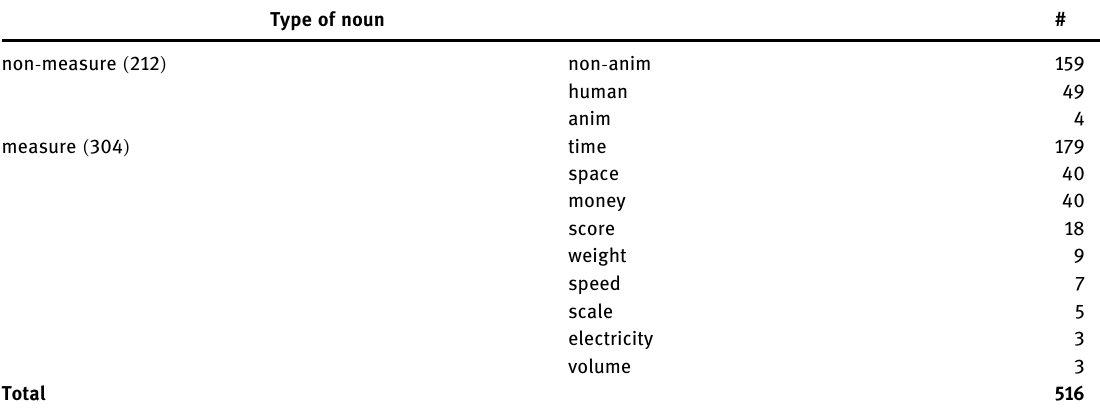
Table 8: Types of noun in Mod - Num NPs